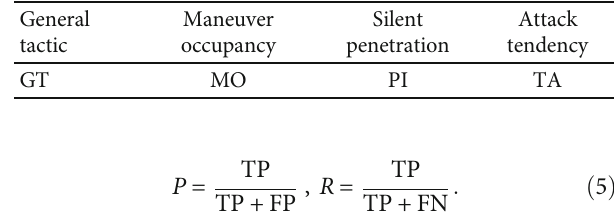
Table 4: Features of cooperative tactical